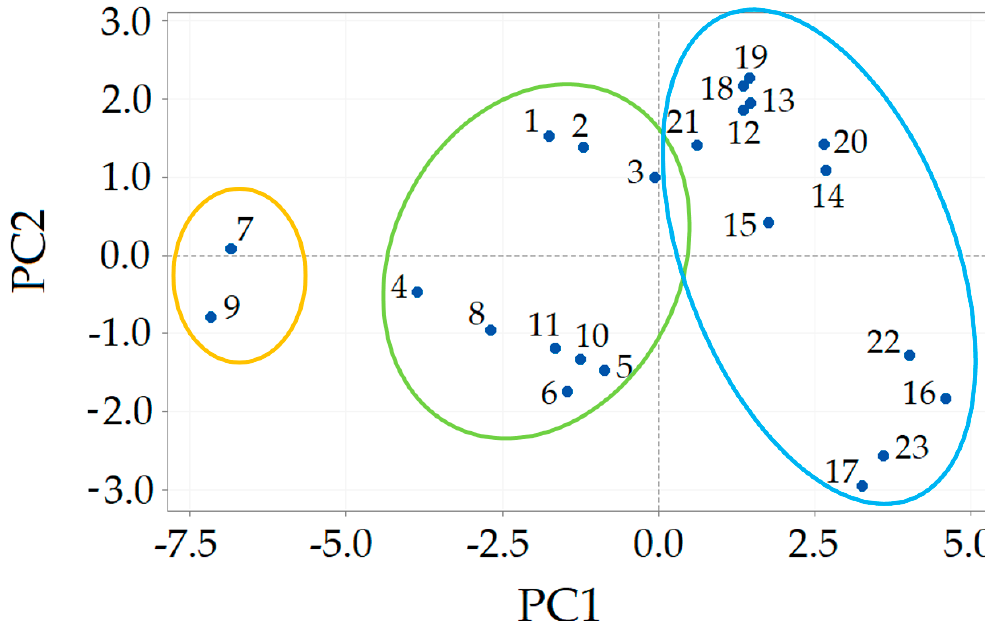
Figure 3. Principal components analysis (PCA) plot of all thermodynamic data including the activity ffi cient, excess enthalpy and Henry’s constant. coefficient, excess enthalpy and Henry’s constant. coe